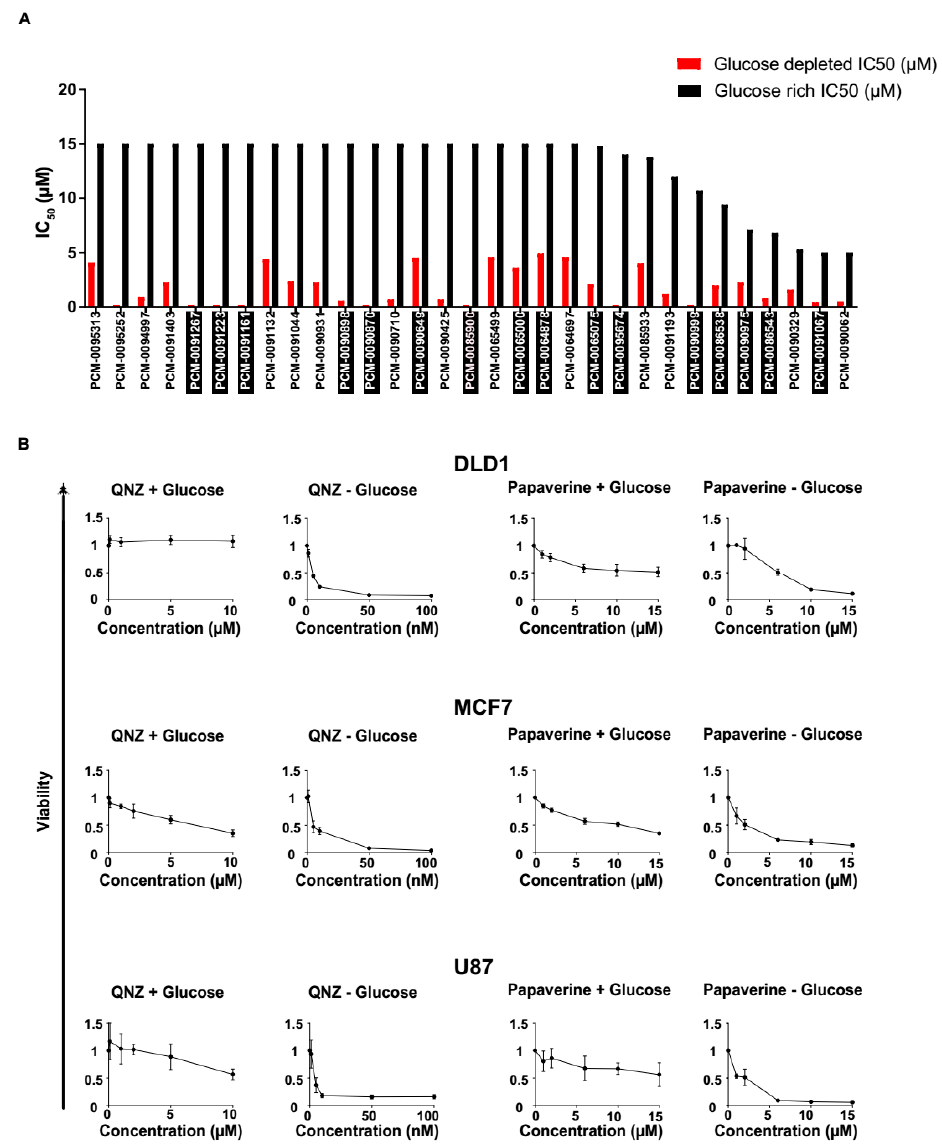
Figure 2. IC 50 of the identified compound hits. ( A ) IC 50 values of the 31 best hits were determined using a Cell-Titer-Glo kit. Compounds with black background are known to be mitochondrial poisons. ( B ) IC 50 values of QNZ or papaverine with DLD1, MCF7 and U87 cells under the indicated conditions were determined using crystal violet staining. Data represents means ± SD; * p < 0.05; n ≥ 3 independent experiments.